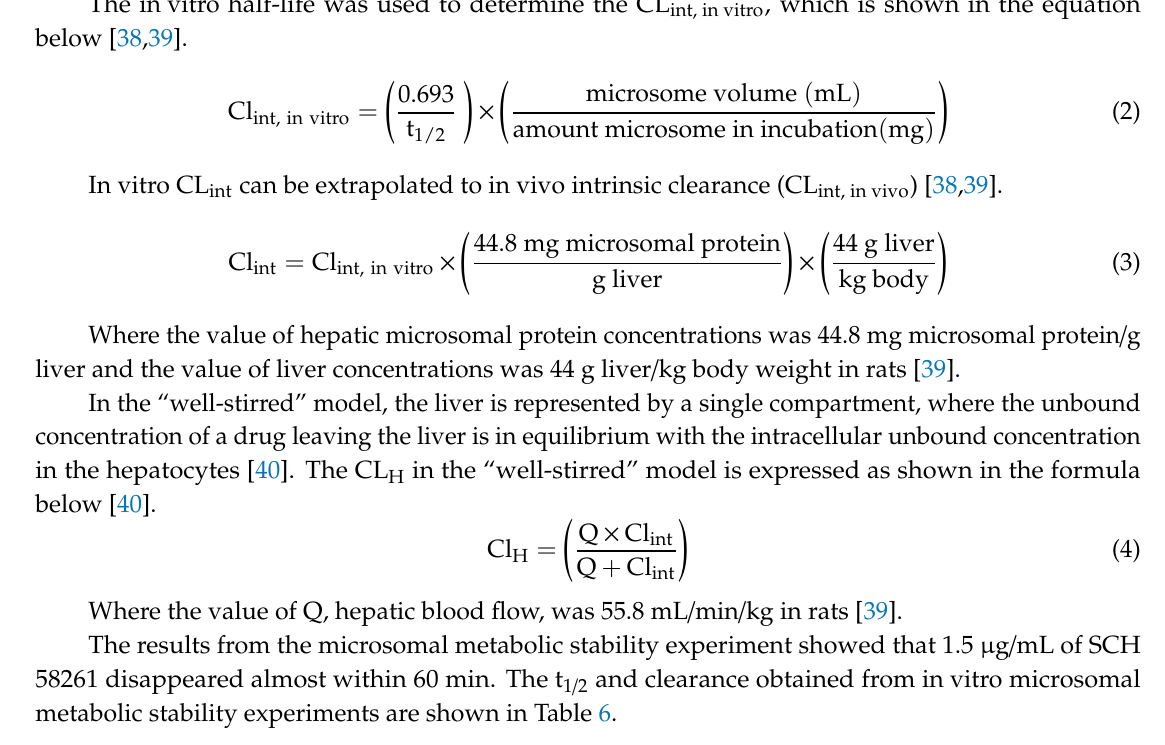
Table 6. In vitro microsomal metabolic stability of SCH 58261 in rat liver microsomes. Species t 1 / 2 (min) CL int, in vitro (mL / min / mg) CL int (mL / min / kg) CL H (mL / min / kg) Rat 10.95 0.063 124.80